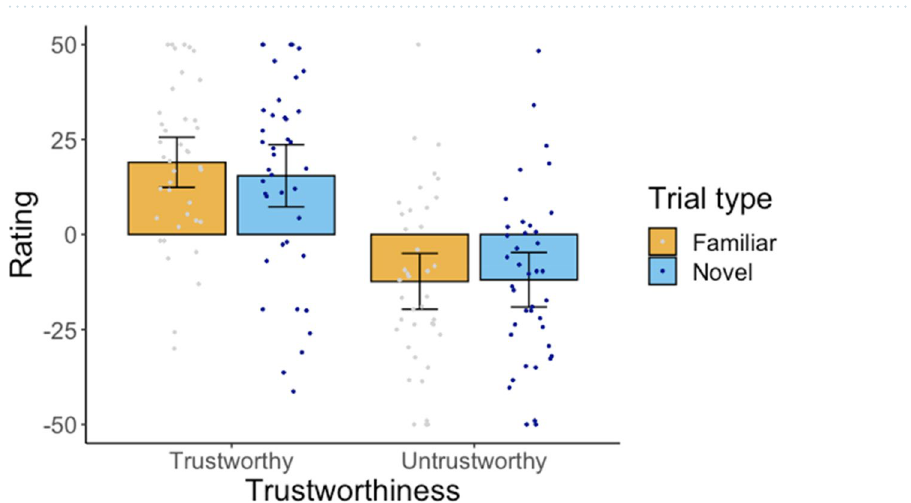
Figure 4. Trial structure in Experiment 4. Stimulus images courtesy of Michael J. Tarr, Carnegie Mellon University, http:// www. tarrl ab. org/.